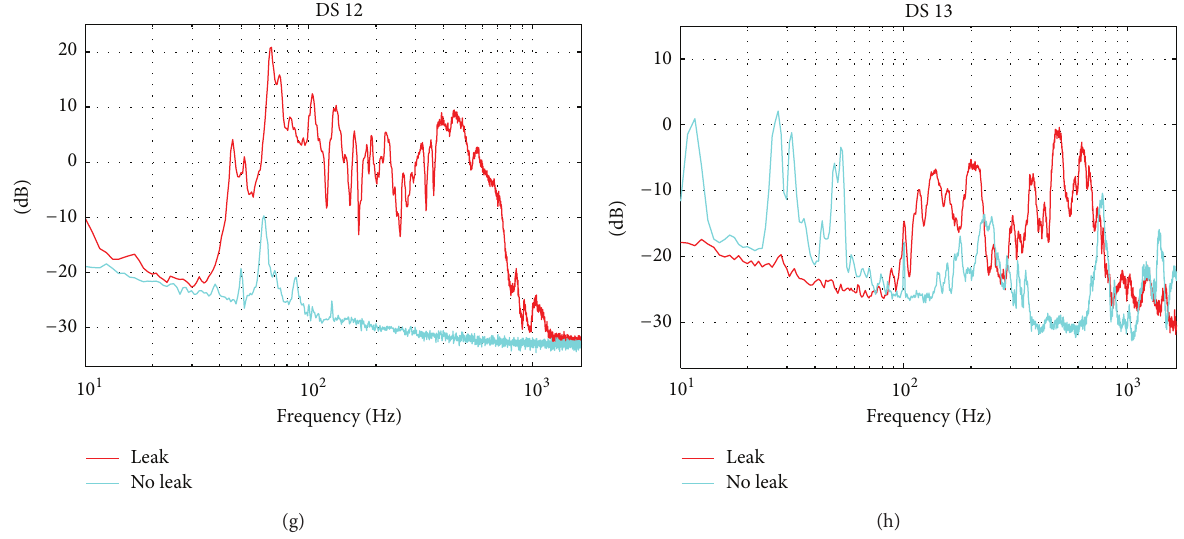
Figure 9: PSD of aggregated signals from datasets (a) DS 2, (b) DS 3, (c) DS 5, (d) DS 7, (e) DS 10, (f) DS 11, (g) DS 12, and (h) DS 13.